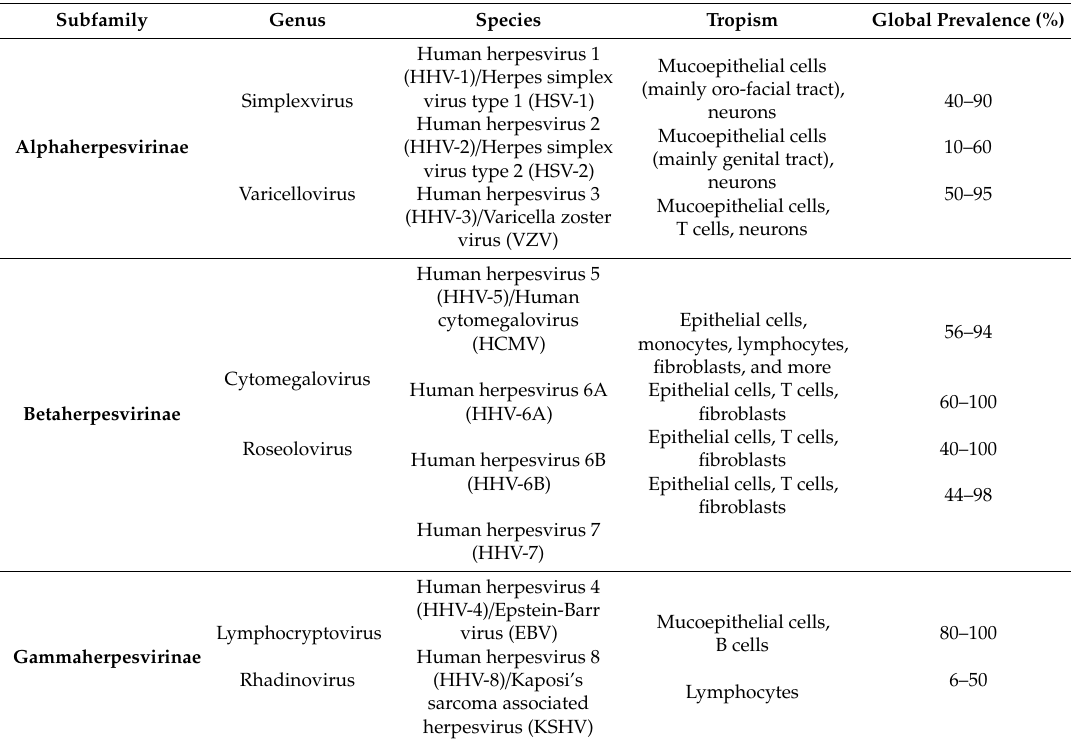
Table 1. Classification of human herpesviruses.